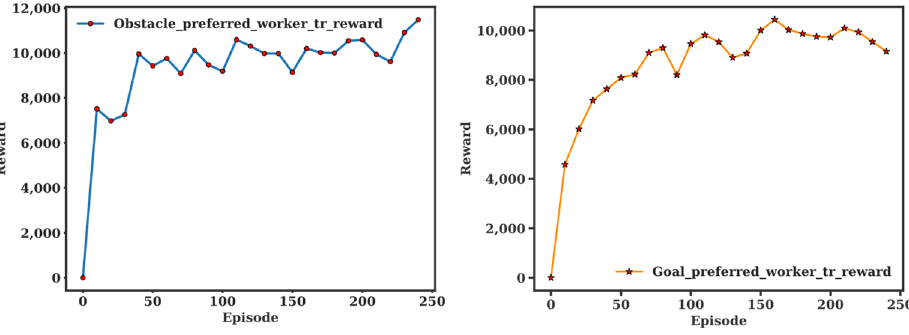
Figure 5. Single DDPG training results with 2 conflicting goals (path planning and collision avoidance).